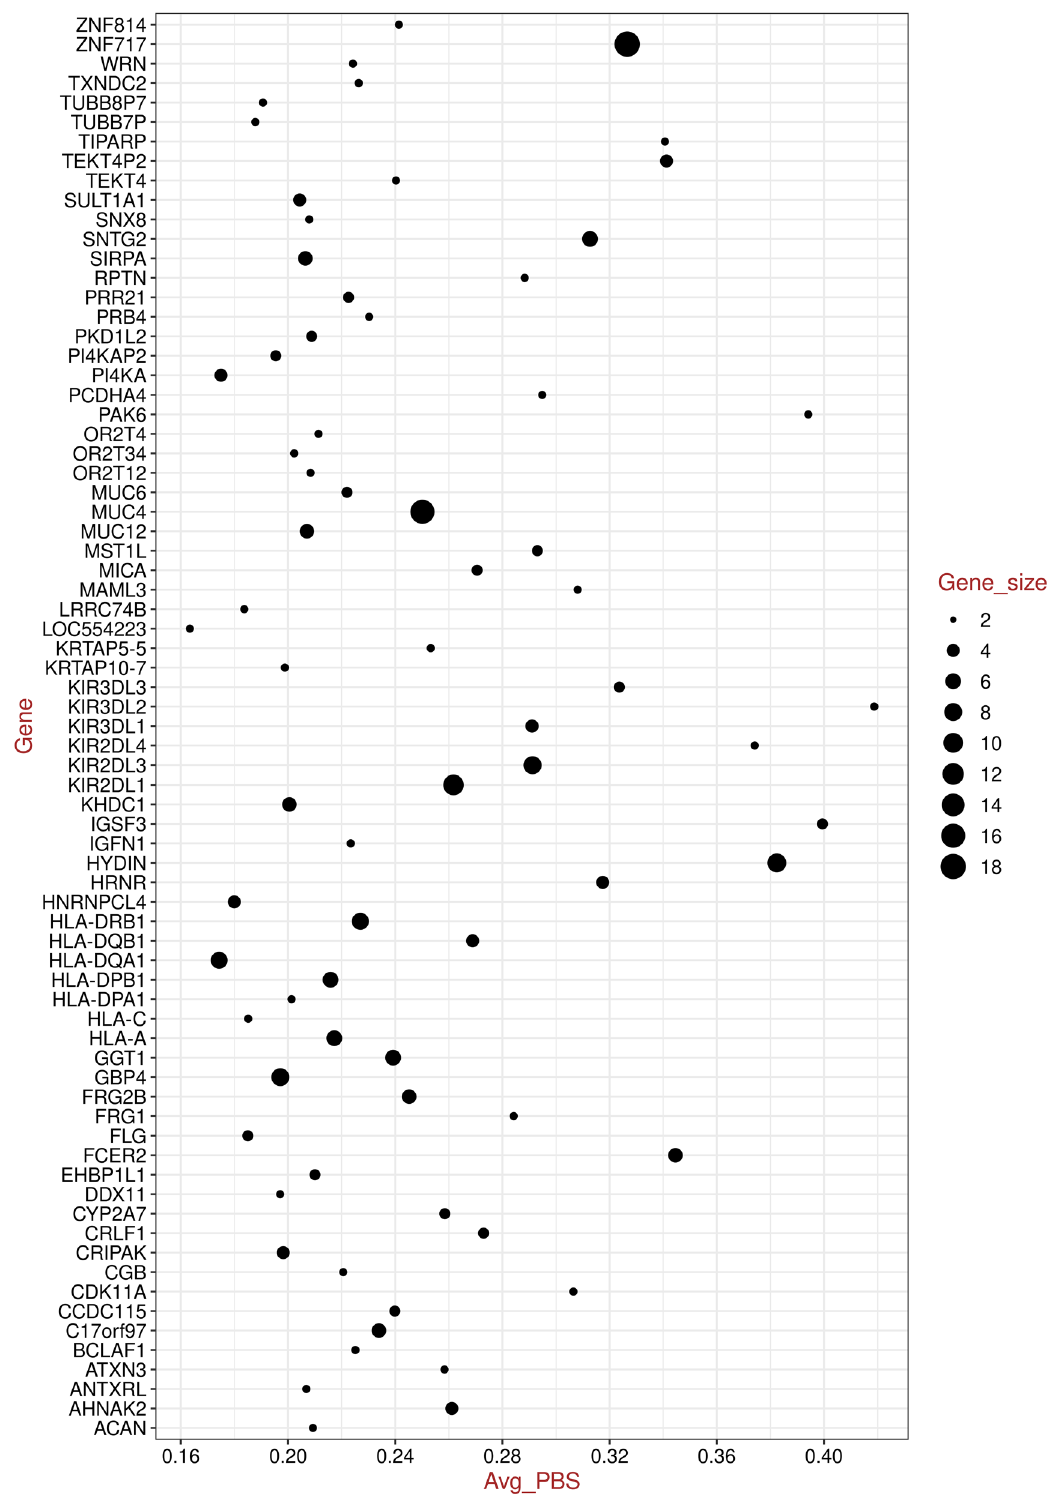
Figure 1. Dot plot of genes with multiple SNPs against the average PBS value; the dot size varies based on gene size (number of SNPs). While plotting we removed the gene SARM1 that was behaving as an outlier (average PBS value = 0.89591), for better